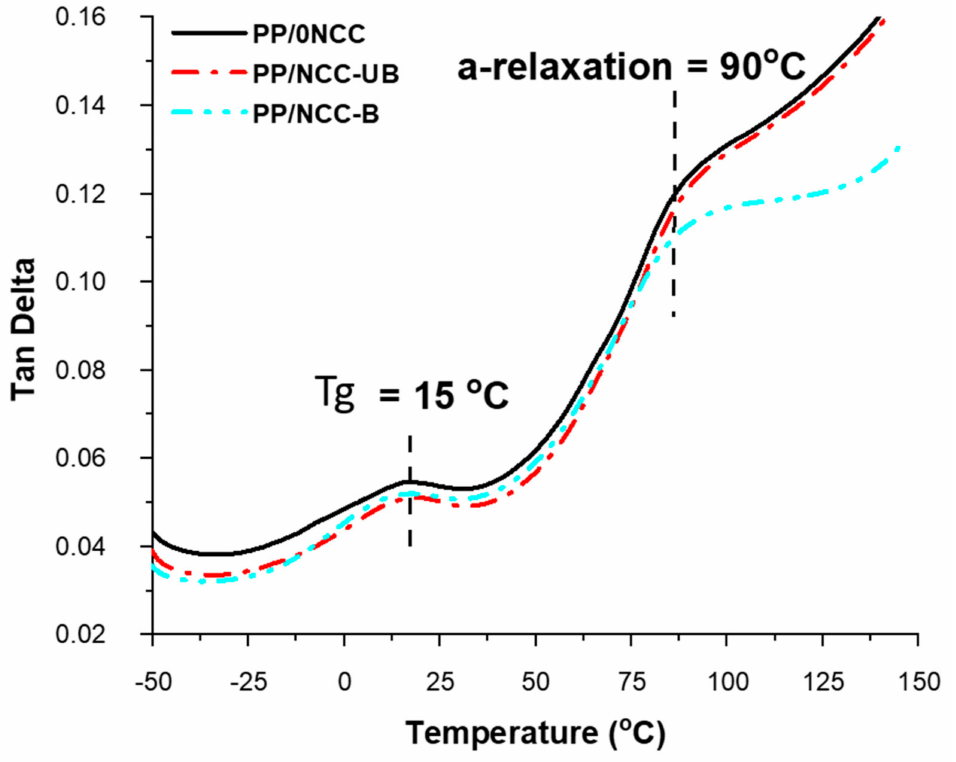
Figure 8. The tan delta graph of kenaf core nanocomposites for reinforced bleached and unbleached